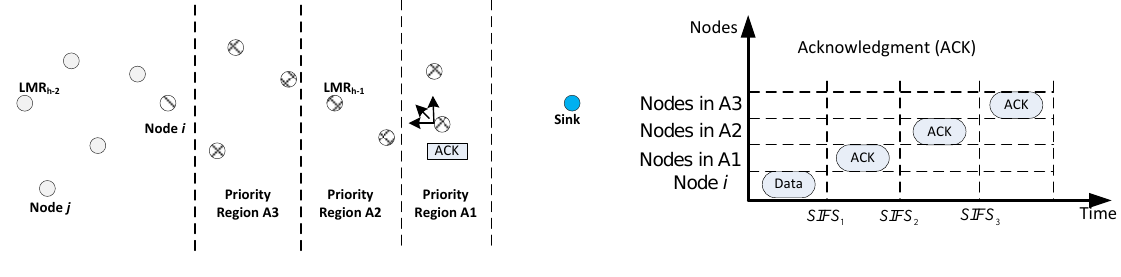
Figure 8. Receiver contention prioritization and backoff